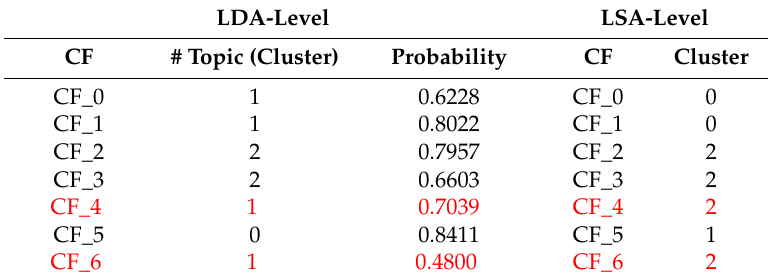
Table 8. Results of the Comparison of the Semantic Clusters as a set of CF Labels.